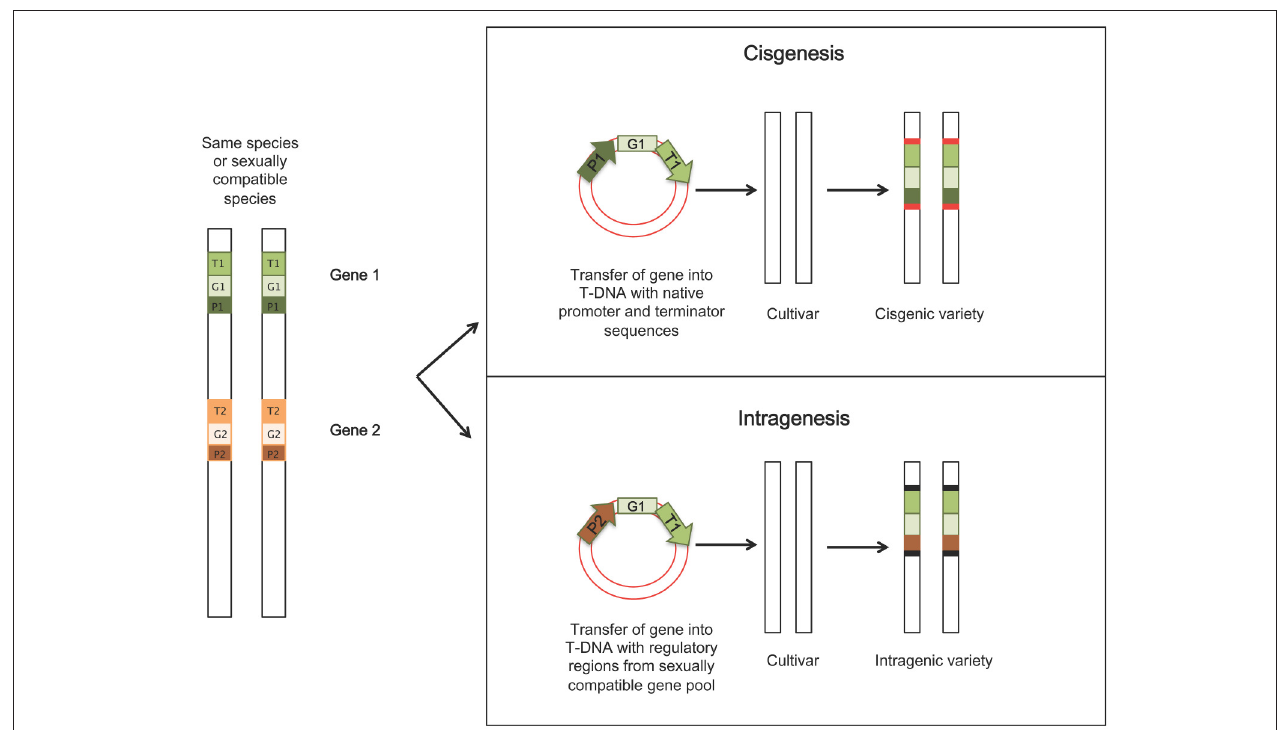
FIGURE 1 | Illustration of principles and procedures of obtaining cisgenic and intragenic crops. In cisgenesis, the new trait is derived from a sexually compatible species and it is transferred to the recipient as it is, including the Agrobacterium -derived T-DNA borders; in intragenesis, the gene construct is a hybrid of different components from different genes within the same species or sexually compatible species. Red boxes: Agrobacterium -derived T-DNA borders; black boxes: borders belonging to sexually compatible DNA pool (P-DNA borders), when using Agrobacterium -mediated transformation. P, promoter; G, engineered gene; T, terminator.